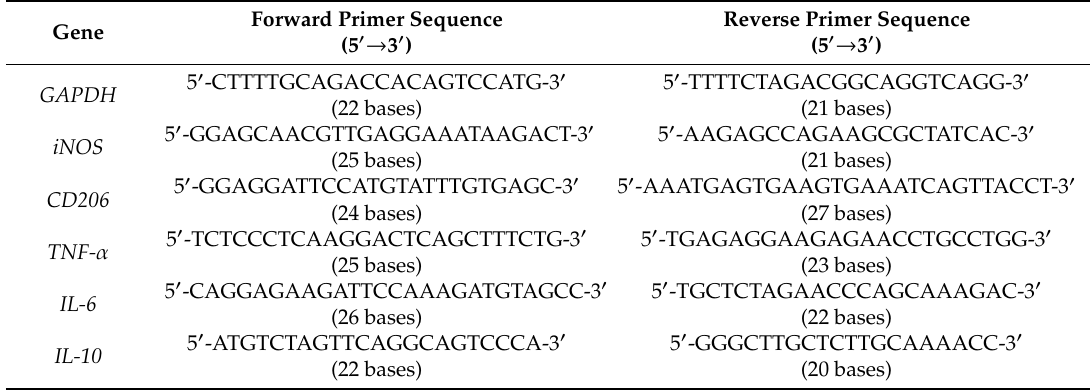
Table 1. RT-PCR primer sequences for tested